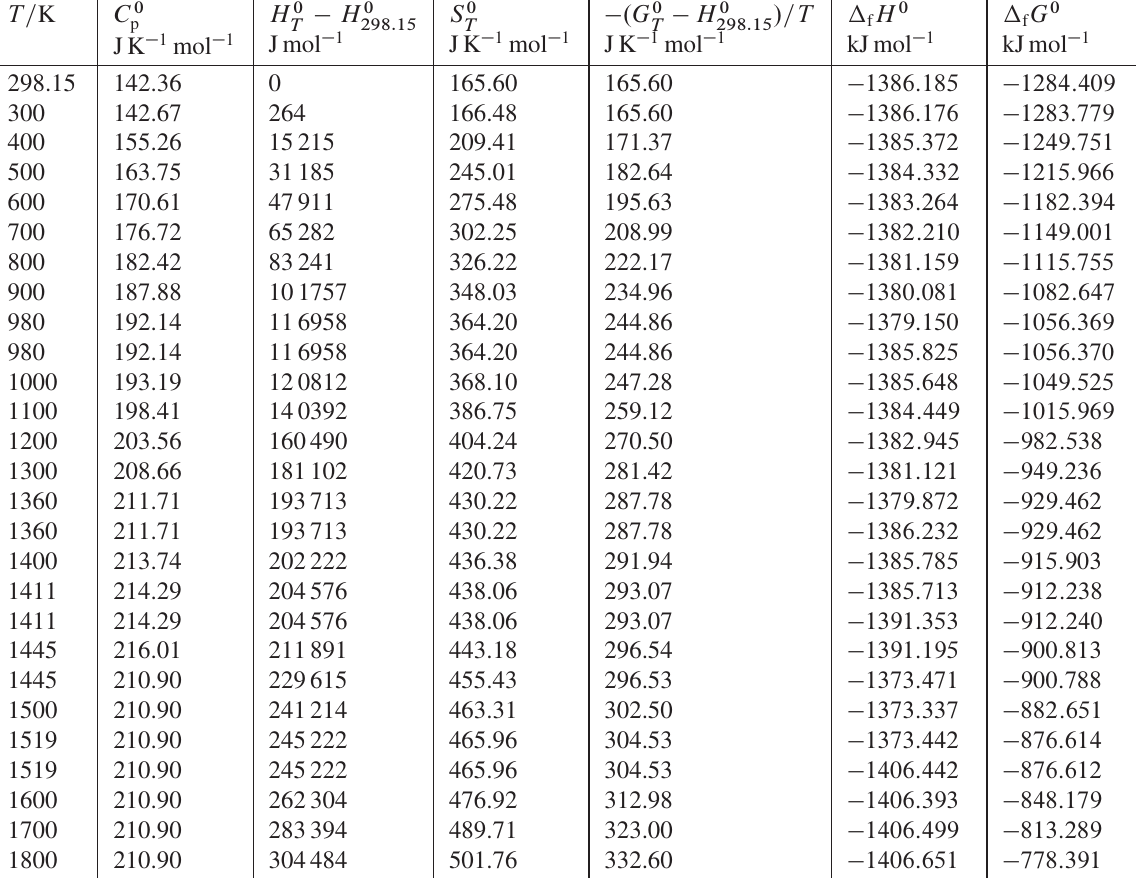
Table 4. Reassessed thermodynamic data for Mn 3 O 4